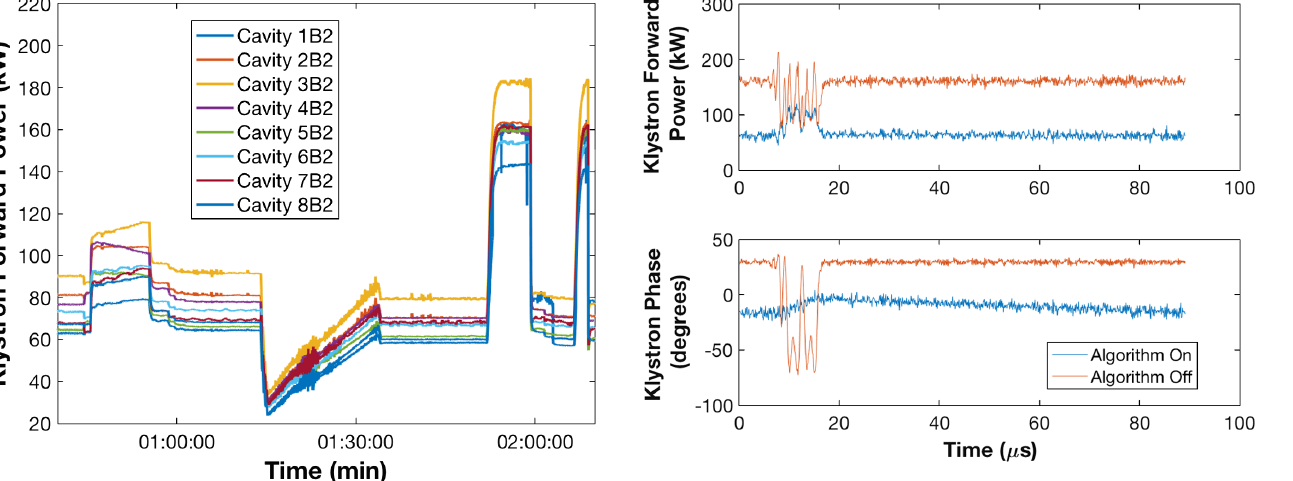
FIG. 11. Average klystron forward power. 1164 bunches, beam 2.